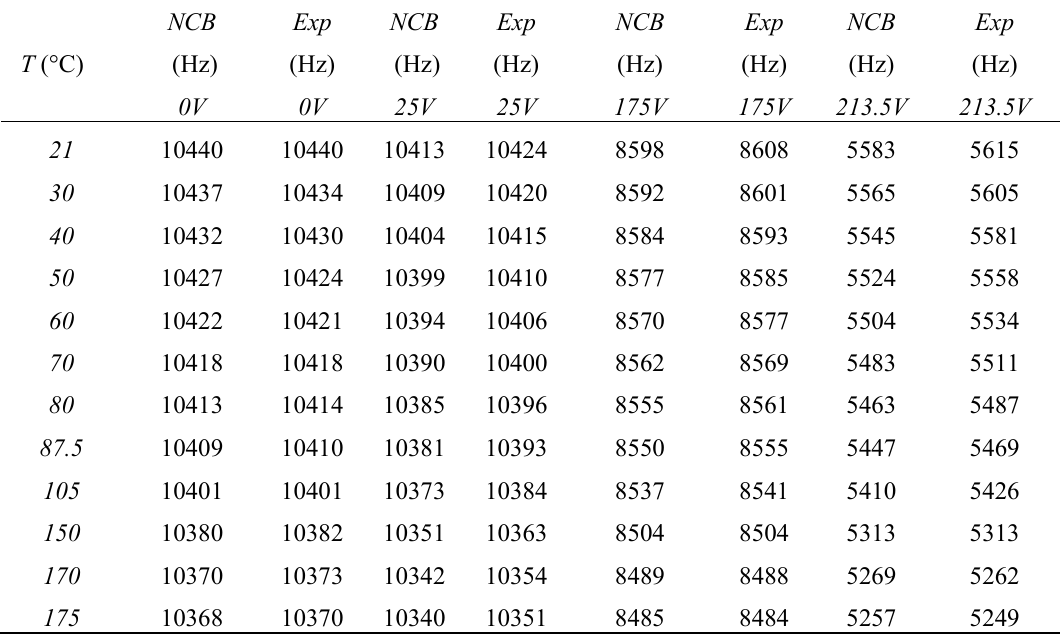
Table 2. Electro-thermal dependence of the resonant frequency for the G1 AFM cantilever. Experimental ( Exp ) and non-classical boundary ( NCB ) support theory.